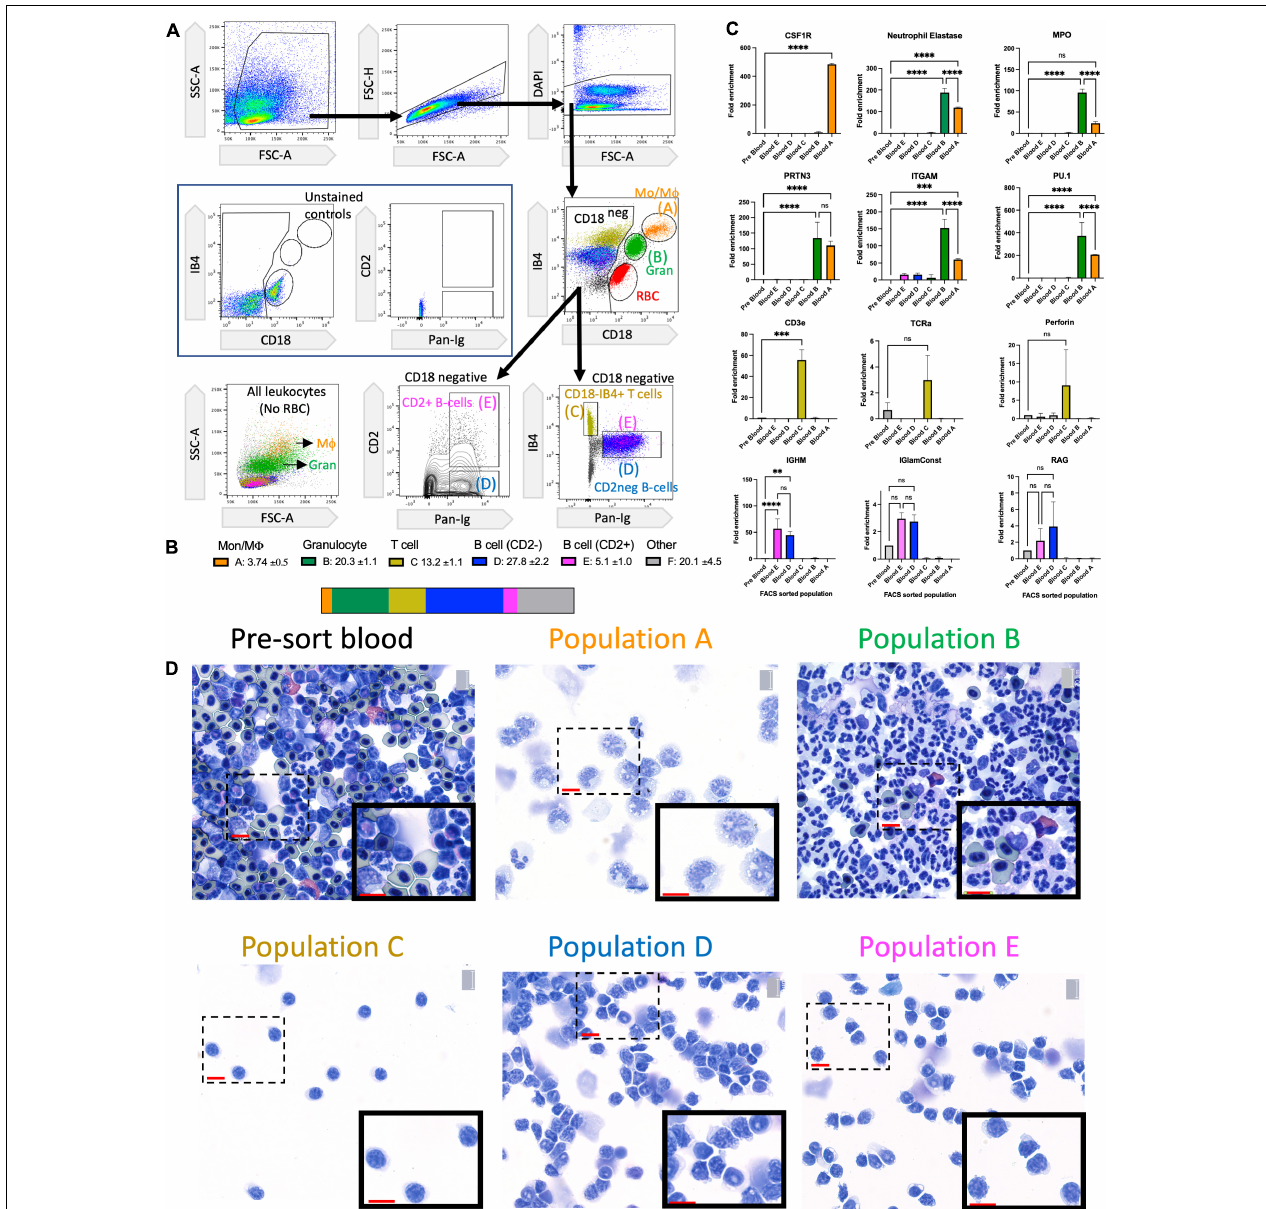
FIGURE 1 | Identification of major leukocyte subsets in the axolotl peripheral circulation. (A) Flow cytometry gating strategy to identify viable circulating single-cell leukocytes in adult axolotls. Use of anti-CD18 and IB4 lectin to identify Monocyte/Macrophage (orange), Granulocytes (green), and RBCs (red). Use of the anti-Pan-Ig, anti-CD2, and IB4 lectin to identify T cells as well as two subsets of B cells. Populations are labeled A–E. (B) Enumeration and visualization of approximate cell subset frequency within total leukocyte population pool. The mean % of non-RBC shown for each population and SD is based on four biological replicates. (C) RT-PCR validation of population identity within FACS sorted populations A–E using representative cell-specific genes. Fold enrichment is calculated relative to pre-sorted blood. Significance calculated using two-way ANOVA with Turkey’s multiple comparisons test indicated as ns p > 0.05, ∗∗ p ≤ 0.01, ∗∗∗ p ≤ 0.001, and ∗∗∗∗ p ≤ 0.0001 (D) Cytospins of FACS sorted populations A–E and pre-sort blood stained with Wright–Giemsa. Each population shows a high level of purity. Population A shows monocyte/macrophage morphology. Population B shows typical granulocyte morphology with multilobed nucleus. Populations C–E display typical lymphocyte morphology. 40 × magnification with scale bar = 20 microns. Mo/M φ , monocyte/macrophage; Gran, granulocyte; RBC, red blood